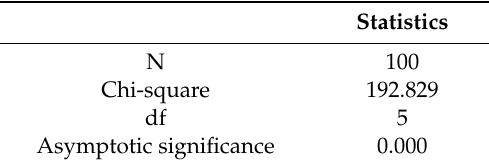
Table 25. Friedman’s test—for each factor of CCCI.